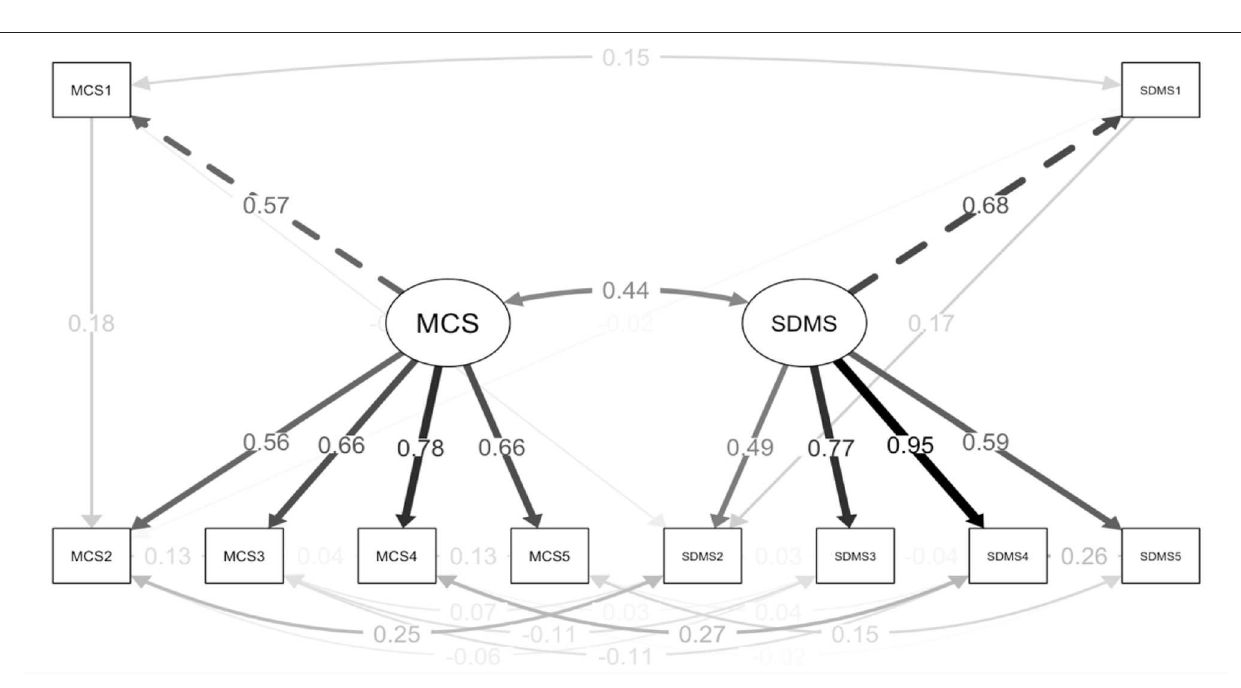
r = 0.16 to r = 0.29 for CI. Although MSC correlated slightly from within-person deviations from mean levels of MCS to